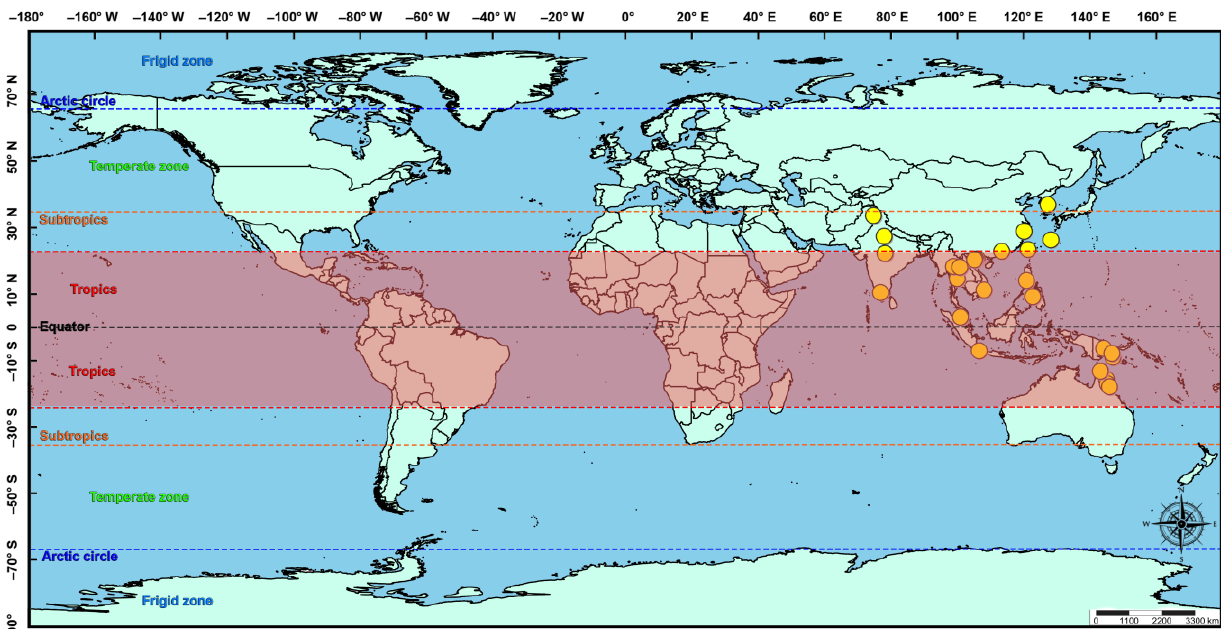
Figure 4. Current geographical distribution of Microplitis manilae in a global context, displayed in yellow points.